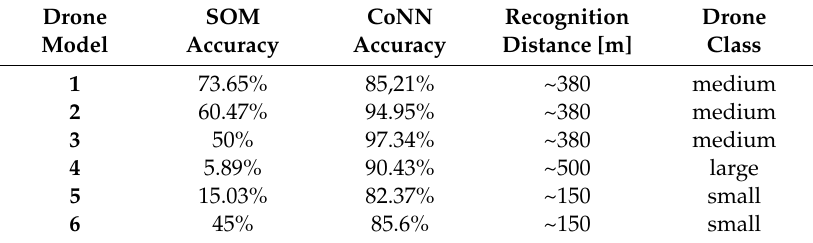
Table 10. Experimental results [%] of recognition and identification of the